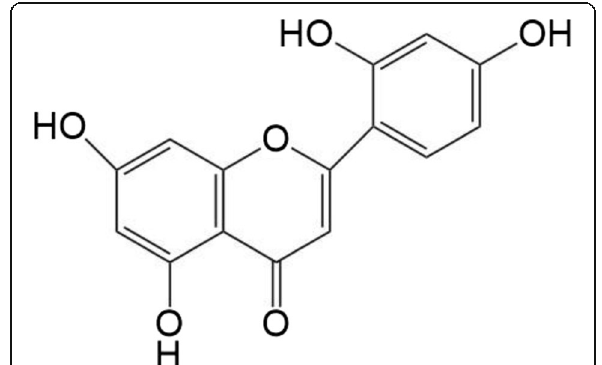
Fig. 1 Chemical structure of Morin